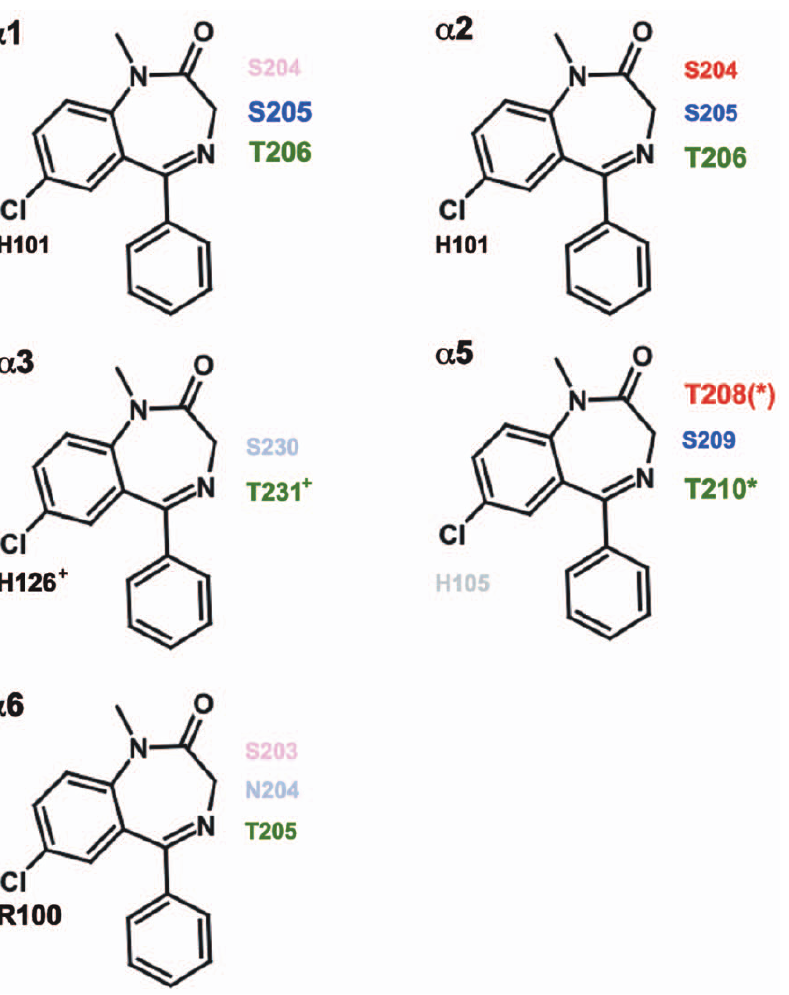
Figure 6. Summary. The results obtained with NCS [33] and the results obtained with 3-NCS described here are summarized. For each receptor isoform a x b 1/2 c 2 (x=1, 2, 3, 5, 6) amino acid residues homologous to 101 in a 1 are shown in black, those homologous to 204 are shown in red, those homologous to 205 are shown in blue and those homologous to 206 are shown in green. Residue 101 is located near to the C atom carrying the Cl atom in diazepam, and 204, 205 and 206 are near to C atom adjacent to the keto group. The residues showing covalent reaction are shown in full color and those showing no reaction coloured in reduced saturation. The residues in larger font size react with a high apparent affinity. The residues marked with * and (*) indicate an antagonistic effect and a partial modulatory effect by 3-NCS on the corresponding a 5m b 2 c 2 receptors, respectively. The residues marked with + indicate that the corresponding a 3m b 2 c 2 receptors were only investigated at the functional